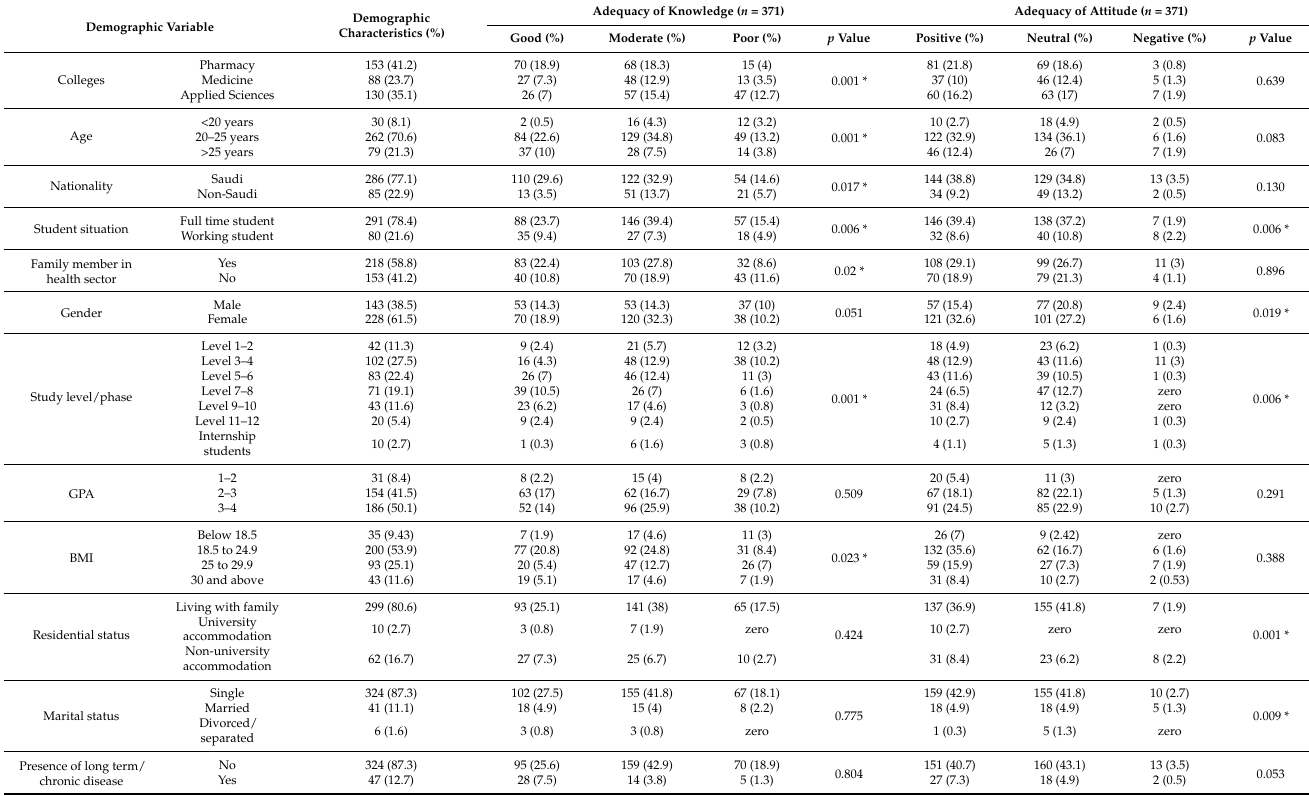
Table 1. Socio-demographic characteristics and their association with the adequacy of knowledge and attitude towards self-medication